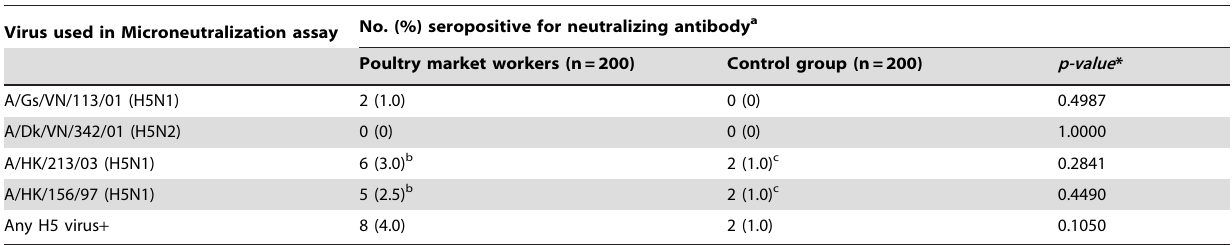
Table 1. Number and percent of live poultry market workers and non-poultry worker controls whose serum tested positive for neutralizing antibody against H5